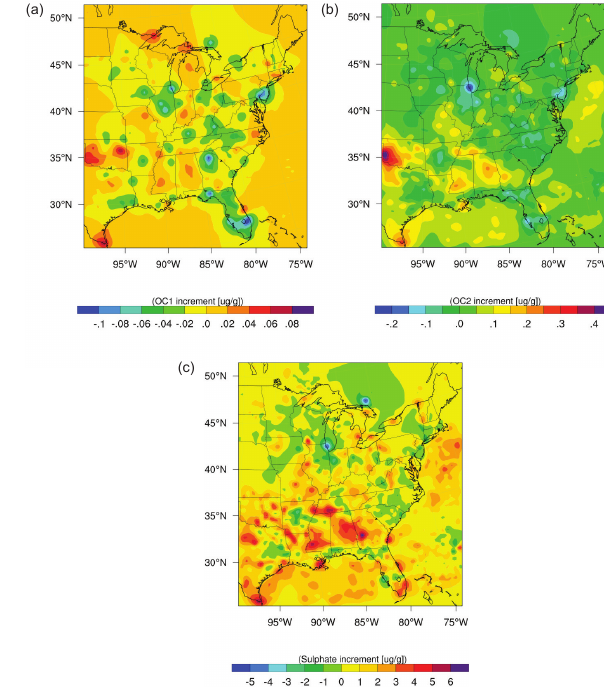
Figure 2. Sample analysis increments of OC 1 , OC 2 , and sulfate (from the top) on the first model